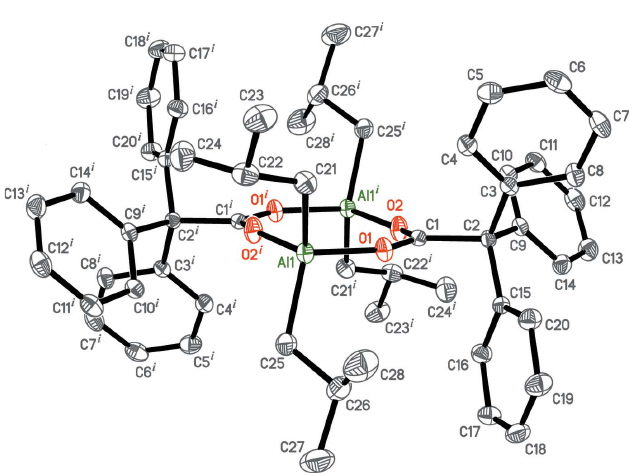
Figure 2 The molecular structure of [Al(iBu) 2 (O 2 CCPh 3 - (cid:2) - (cid:3) O : (cid:3) O 0 )] 2 . Displace- ment ellipsoids are drawn at the 50% probability level and H atoms have been omitted for clarity. [Symmetry code: (i) (cid:3) x , (cid:3) y + 1, (cid:3) z + 1.]